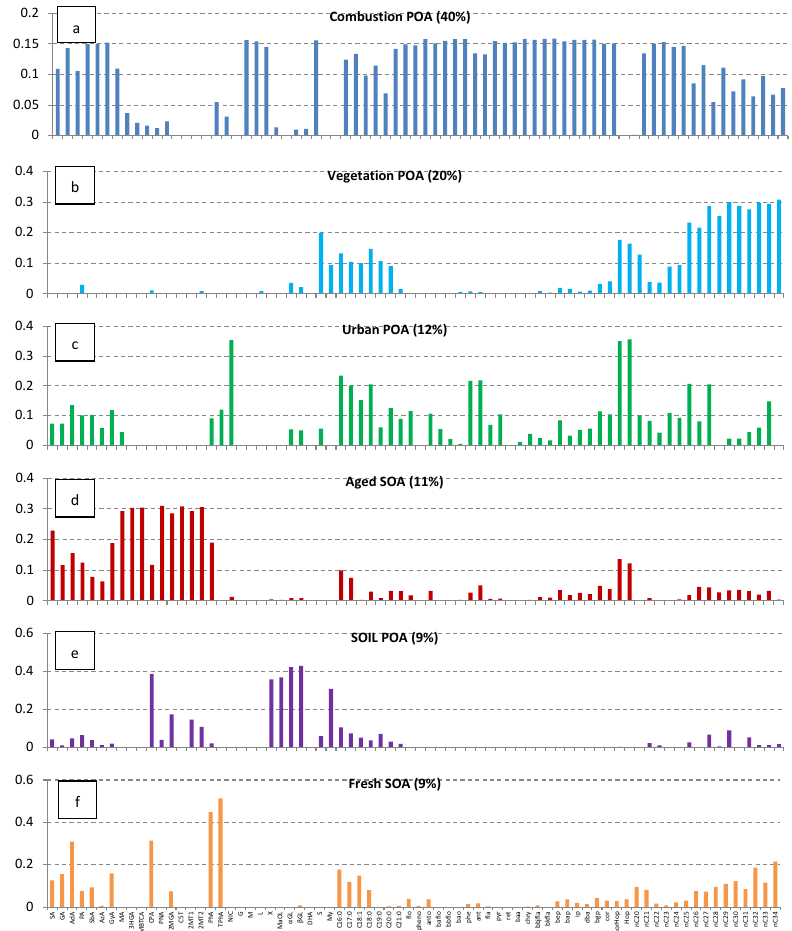
Figure 5. Loading of the six components from MCR-ALS resolved profiles for the organic compound